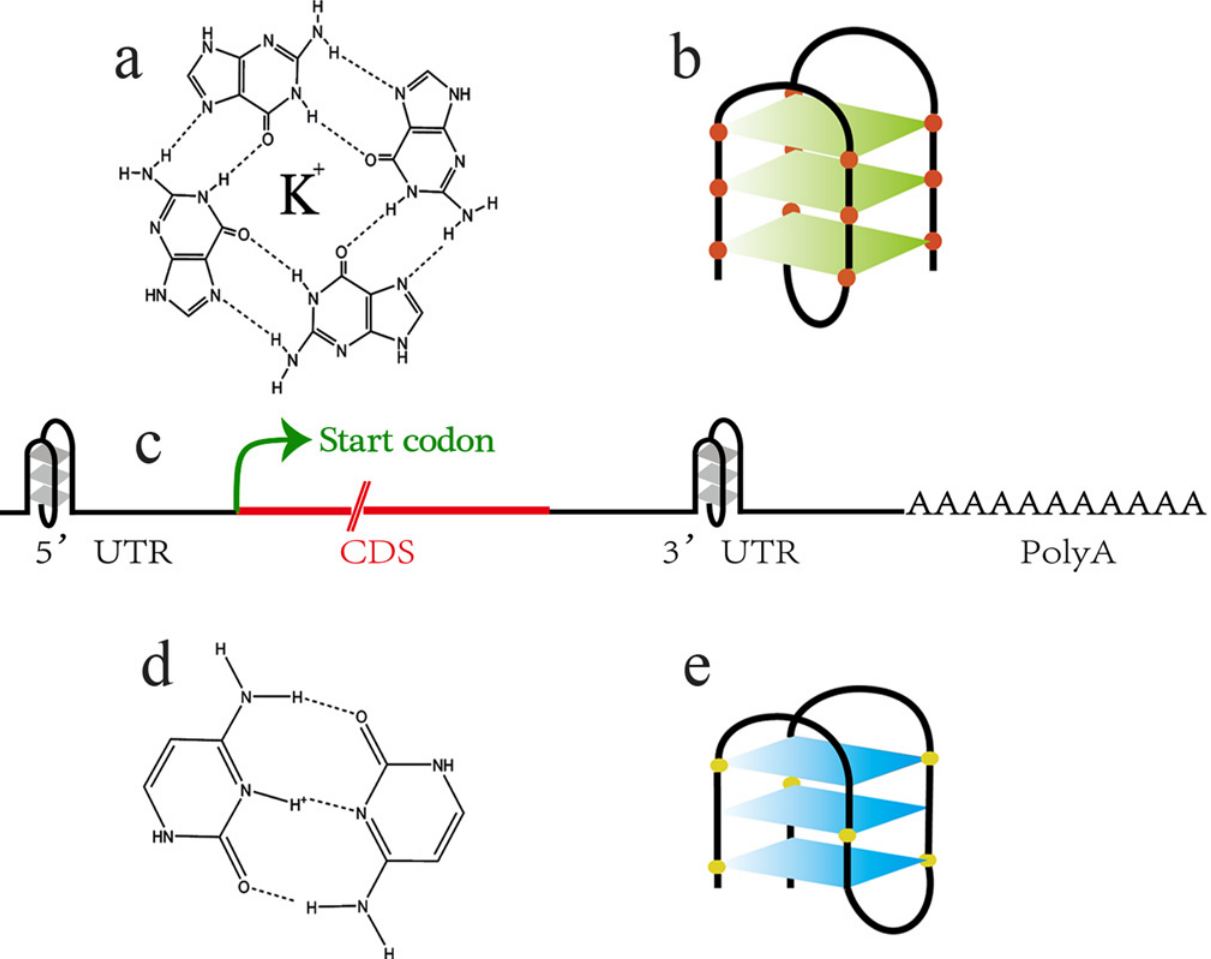
Fig 10. Schematic diagram of a G-Quadruplex (a, b) and an i-Motif structure (d, e). The secondary structure on the Untranscripted Region (UTR) of RNA may have effect on regulation of translation or post-transcription